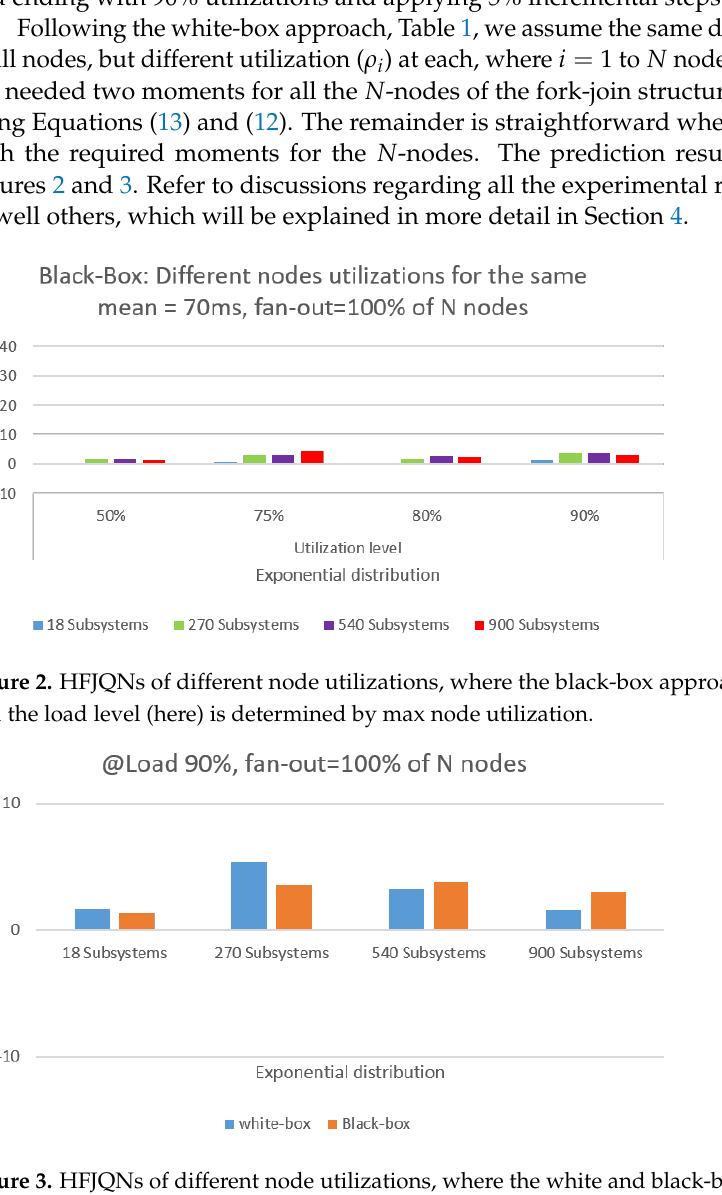
Figure 3. HFJQNs of different node utilizations, where the white and black-box methods prediction performances are compared, given the max node utilization is at load